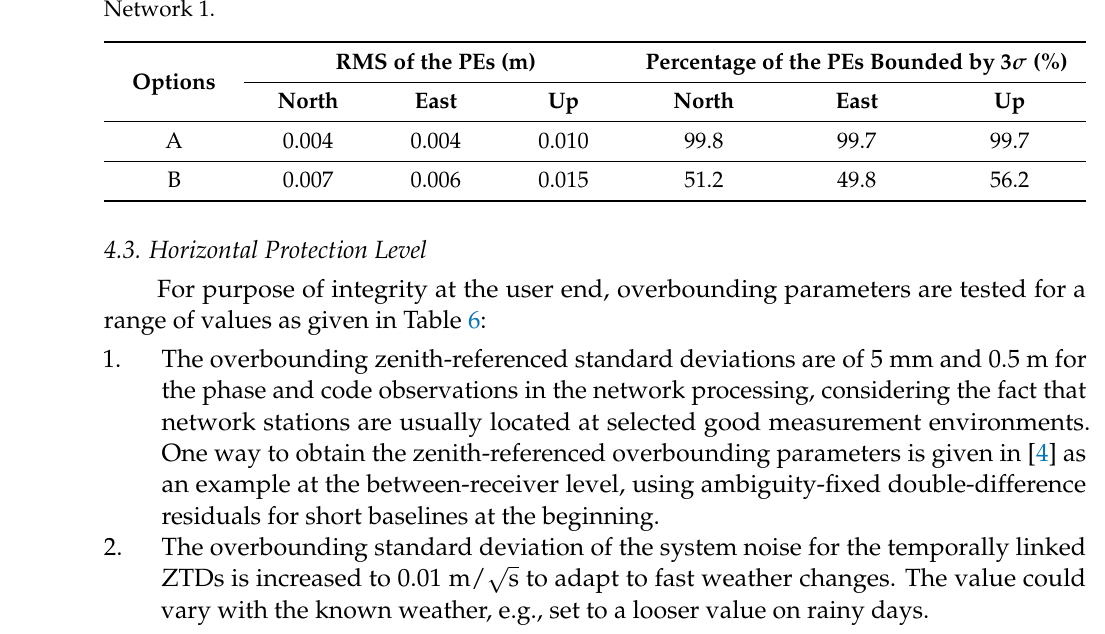
( c ) Figure 5. Formal precision of the between-satellite network corrections of C26 and C29 using: ( a ) Network 1; ( b ) Network 2; ( c ) Network 3 on L1 phase. 𝜎 (cid:3088) (cid:3284)(cid:3285),(cid:3117)(cid:3169)(cid:3171) is set to 1.5 mm. 4.2. User Processing With the satellite clocks, satellite phase biases provided by the network and the ion- ospheric delays interpolated with the help of those of the network stations, the user can resolve the ambiguities and thus achieve high positioning precision. In this section, the observations of the worst-location users (see the stars in Figure 5) are simulated with the noise, the temporally linked ZTDs and hardware biases as defined in Table 4. Spatially correlated ionospheric signals are simulated for both the network stations and the user according to Equation (7). The interpolated ionospheric signals of the network stations are considered in the network corrections in addition to the processing noise. The blue lines in Figure 6 show three times the formal standard deviations of the user positions for Network 1, and the gray lines illustrate the corresponding PEs. The user pro- cessing starts 60 s after the network processing to allow for convergence of the network corrections, i.e., at 00:01:00 in GPST on 26 June 2021. FAR is achieved almost in the entire